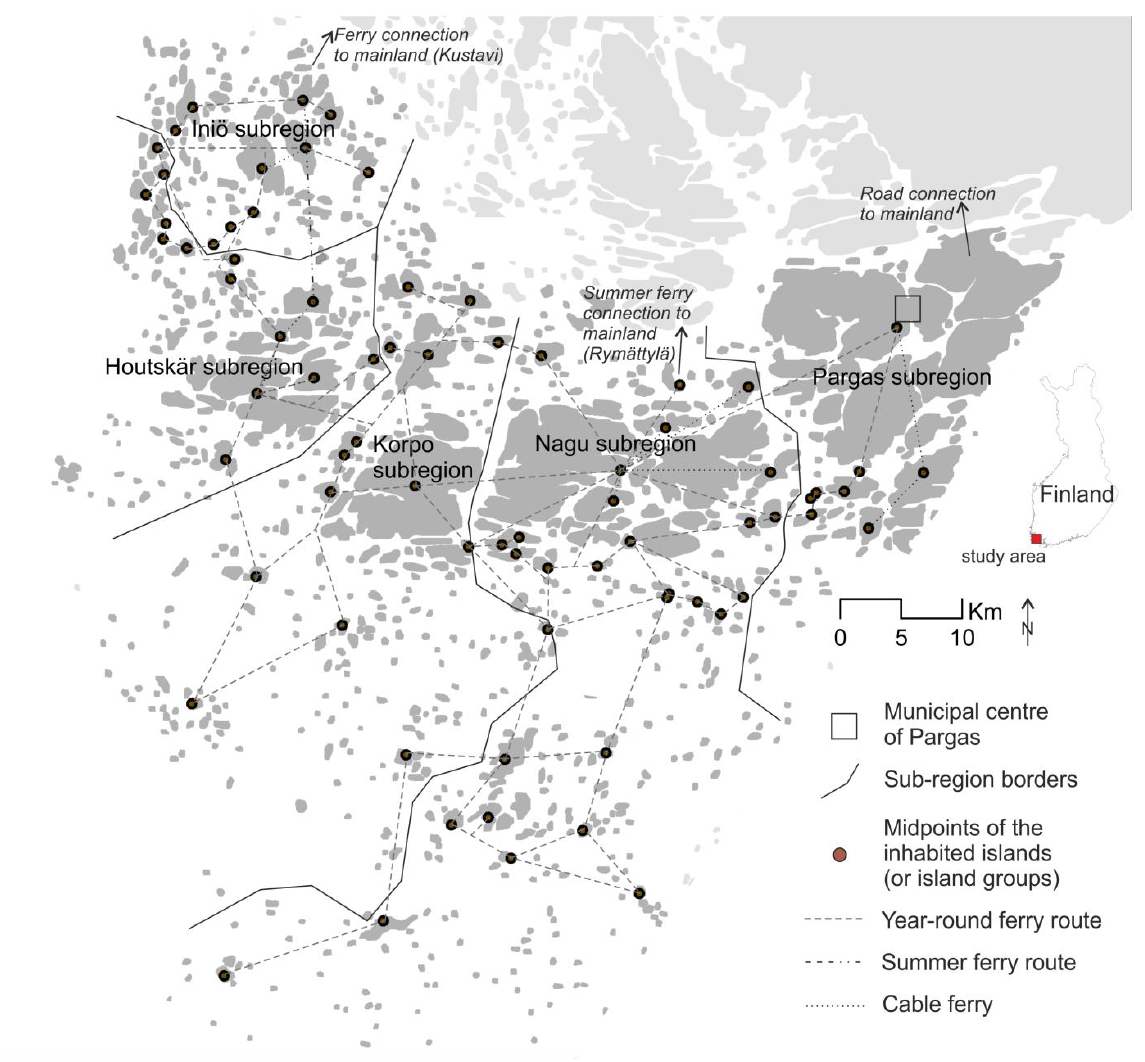
Figure 1. The Pargas archipelago, its five sub-regions (Pargas, Nagu, Korpo, Houtskär and Iniö) and a simplified scheme of the main ferry routes between the islands (only island midpoints have been taken into account, not true pier locations). For true geometries and more detailed ferry route descriptions, see Kajander et al. (2008) and the Centre for Economic Development, Transport and the Environment (2012). Data sources: General map 1:1000000, 2010 © National Land Survey of Finland (background